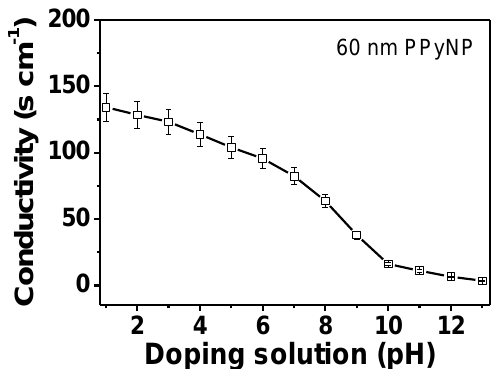
Figure 5. Electrical conductivities of PPyNPs at various pH values.